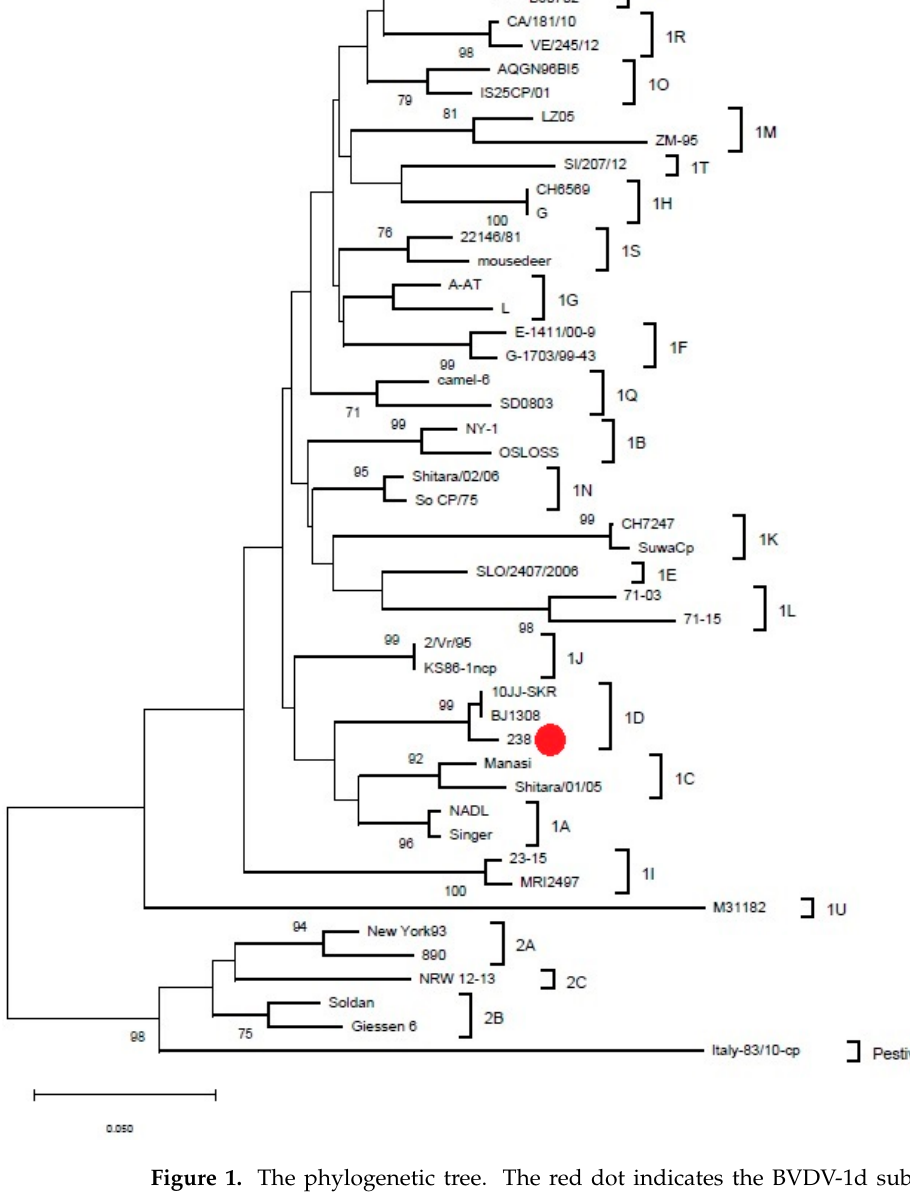
Figure 1. The phylogenetic tree. The red dot indicates the BVDV-1d subgenotype of the male calf in this study (no. 238). BVDV sequences used to generate phylogenetic tree with Gen- Bank accession numbers are provided as they appear in the figure from top to bottom: